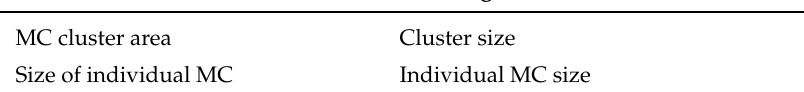
Table 2. Clinical description of the selected features using the OMI-DB database for classification of MC